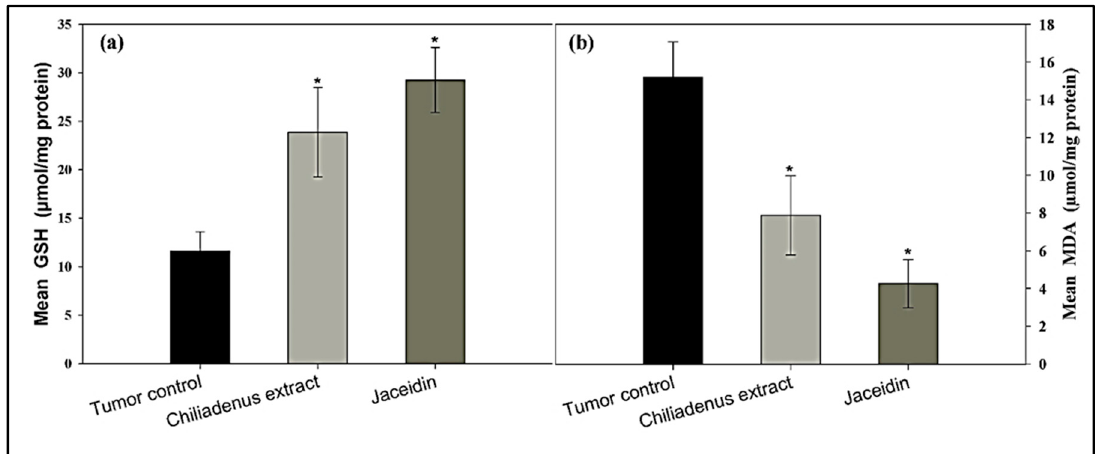
Figure 4. E ff ect of Chiliadenus montanus extract and jaceidin on GSH level ( a ) and MDA level ( b ) in Ehrlich’s carcinoma solid tumors growing in female mice. Data are expressed as the mean ± SD and analyzed using one-way ANOVA followed by Bonferroni’s post-hoc test. * compared to the tumor control group at p < 0.001.